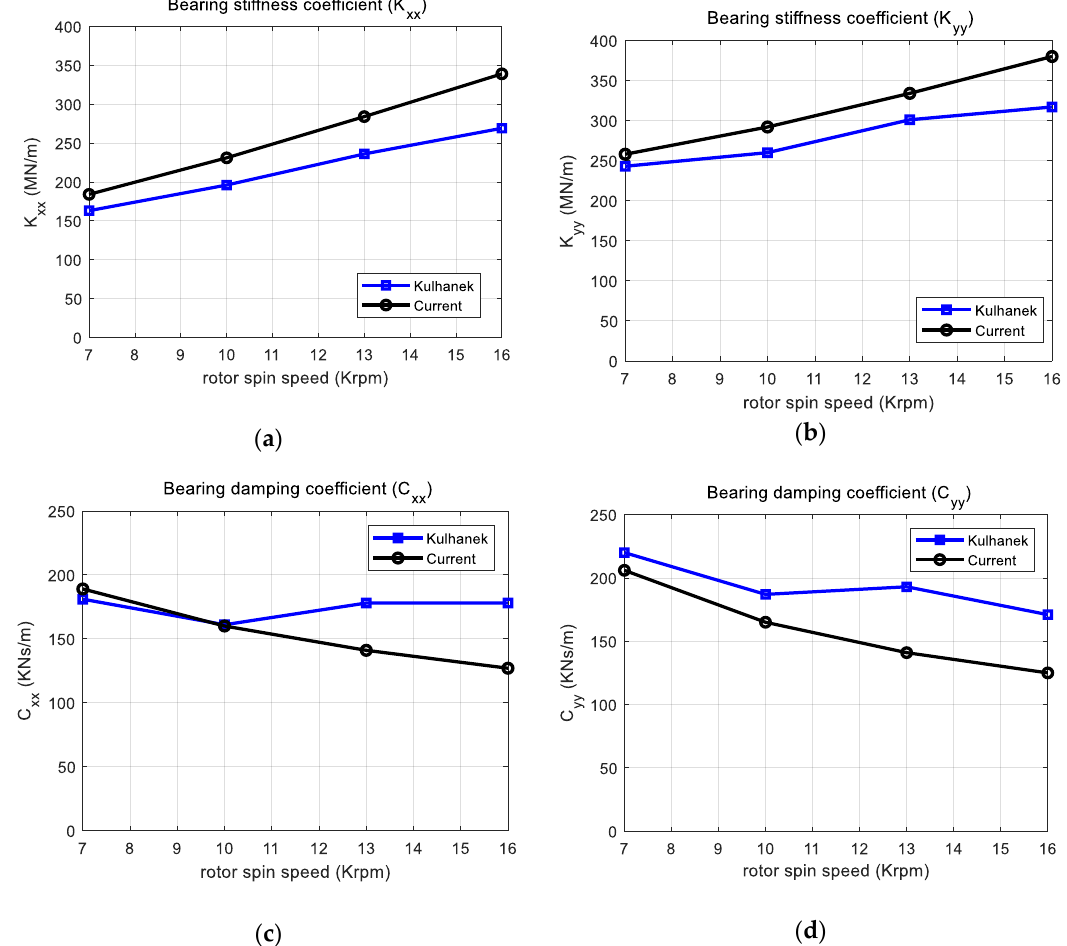
Figure 6. Nondimensionalized dynamic characteristics: ( a ) 𝑘 𝑥𝑥 ; ( b ) 𝑘 𝑦𝑦 ; ( c ) 𝑐 𝑥𝑥 ; ( d ) 𝑐 𝑦𝑦 .